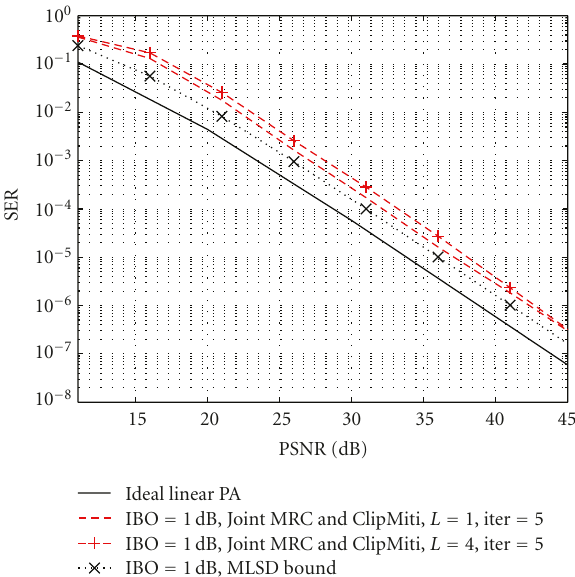
Figure 4: SER performance of the joint MRC and clipping mitigation method for both the Nyquist-rate and oversampling OFDM system. The SER curves of the ideal linear PA and the MLSD bound in (22) with IBO = 1 dB are also shown for comparison. N r = 2.